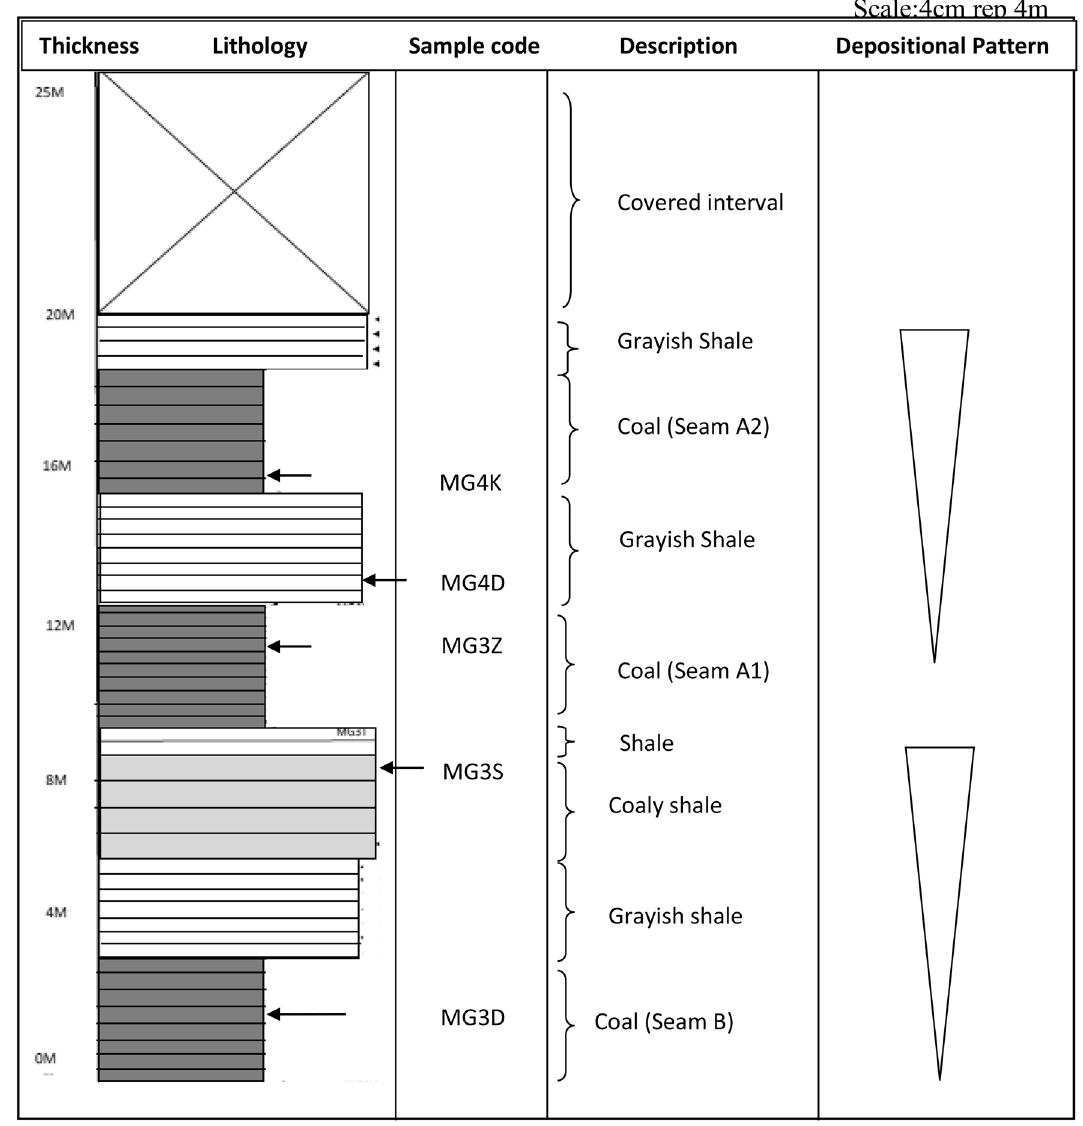
Fig. 5 Lithologic succession of Gombe Formation at Maiganga mine (Phase II). The succession coarsens upward from coal, shale, coaly shale. The arrows indicate the selected and analysed samples. Coordinates: (10°04 ′ 46 ″ N, 11°12 ′ 23 ″